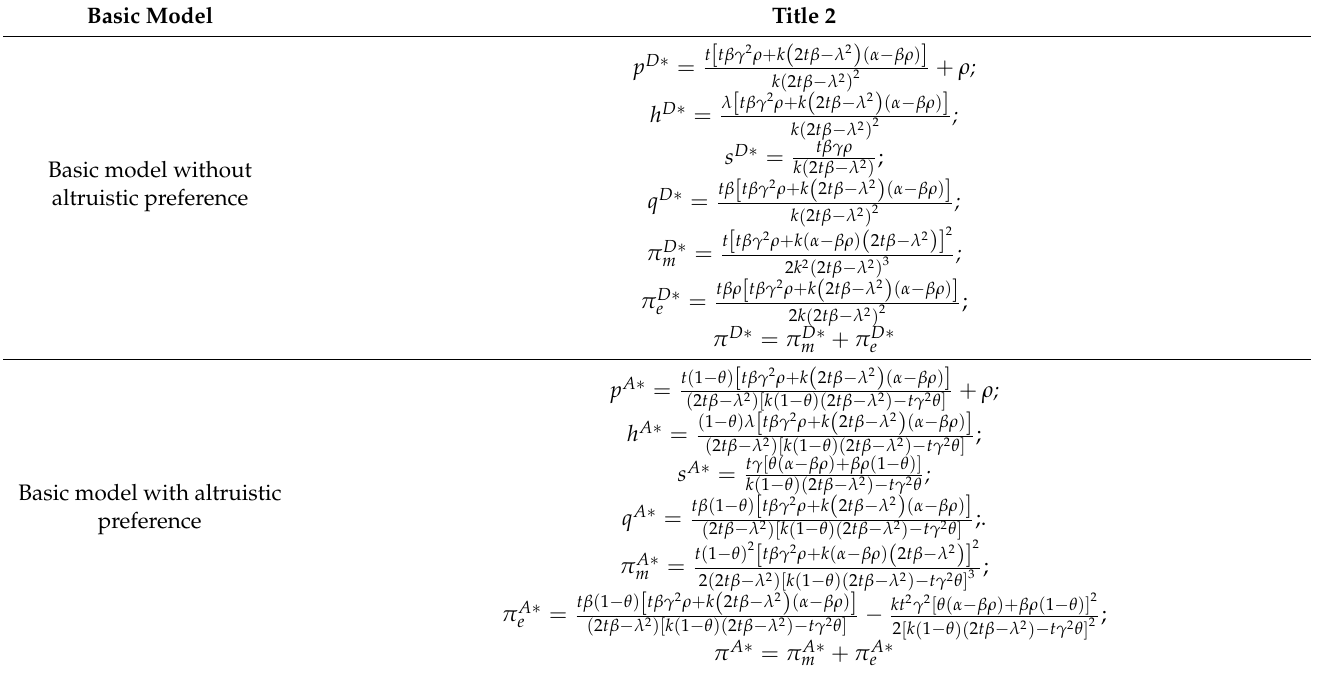
Table 2. The optimal decision and corresponding profit under the basic